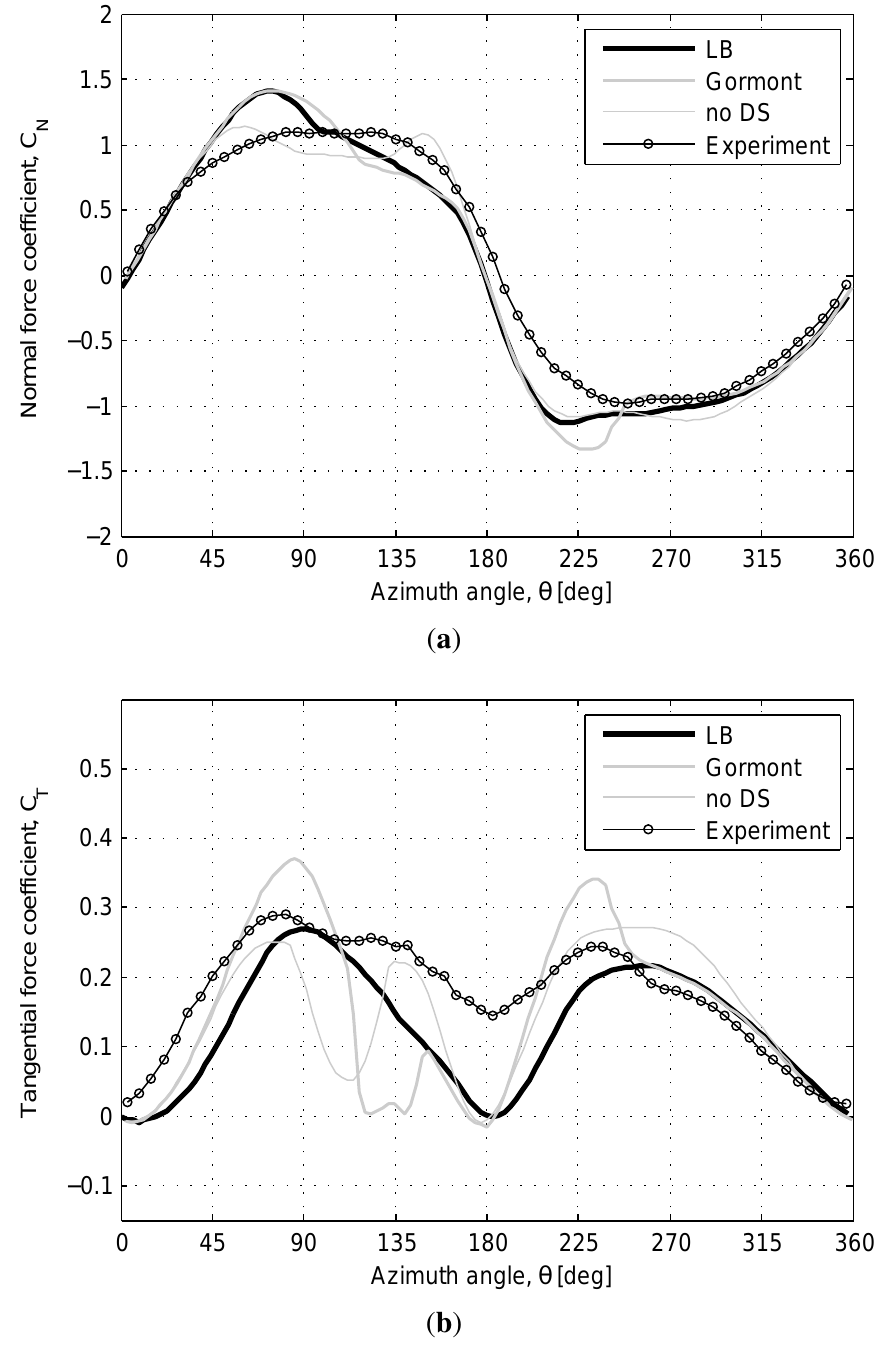
Figure 10. Force response at a TSR of 3.09. ( a ) Normal force; ( b ) tangential